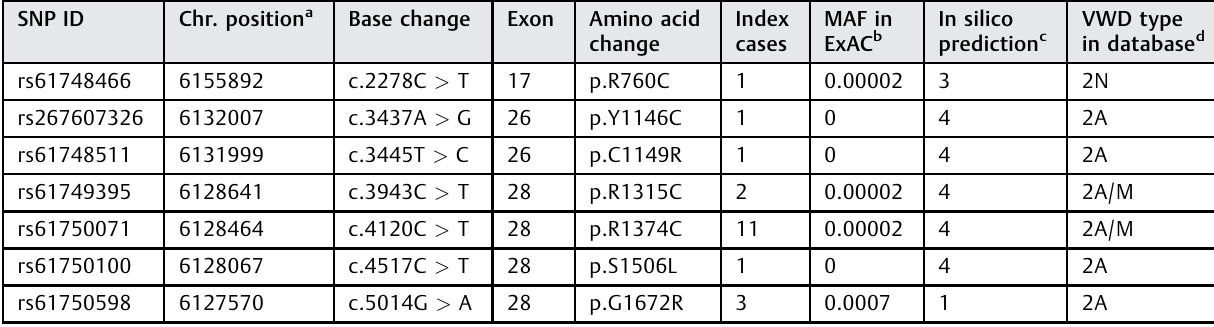
Table 1 Type 2 VWD mutations identi fi ed among the 126 index cases SNP